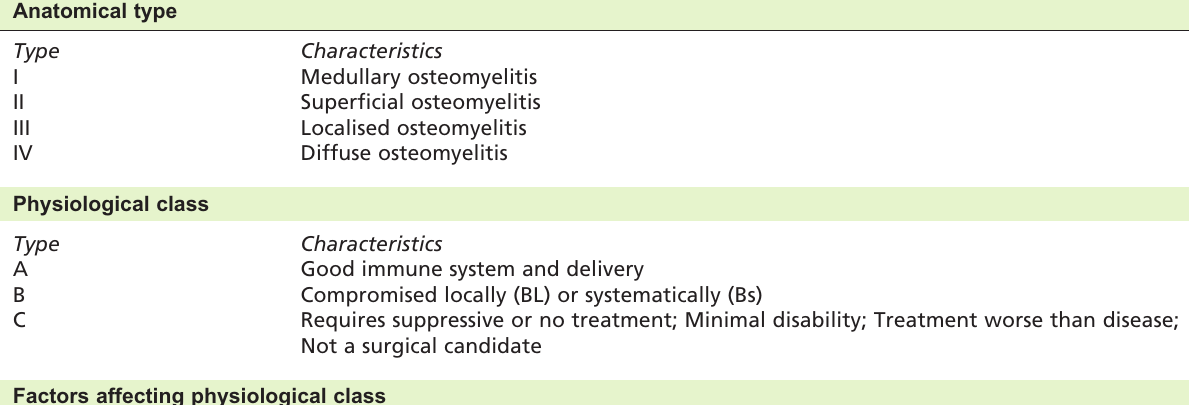
Cierny and Mader’s classification of Table I: